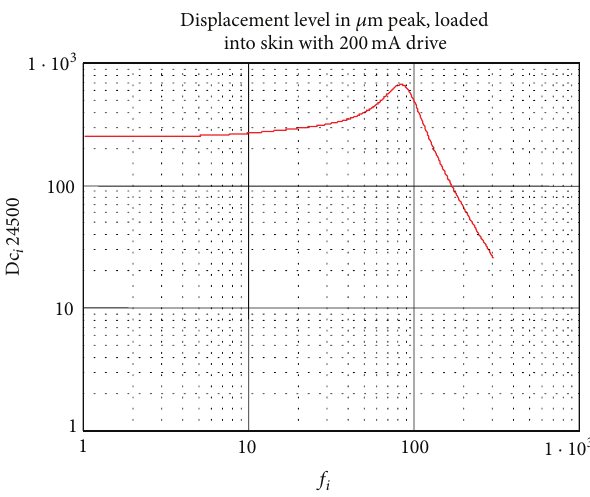
Figure 3: Frequency response of the vibrator C2-tactor. Adapted by permission from